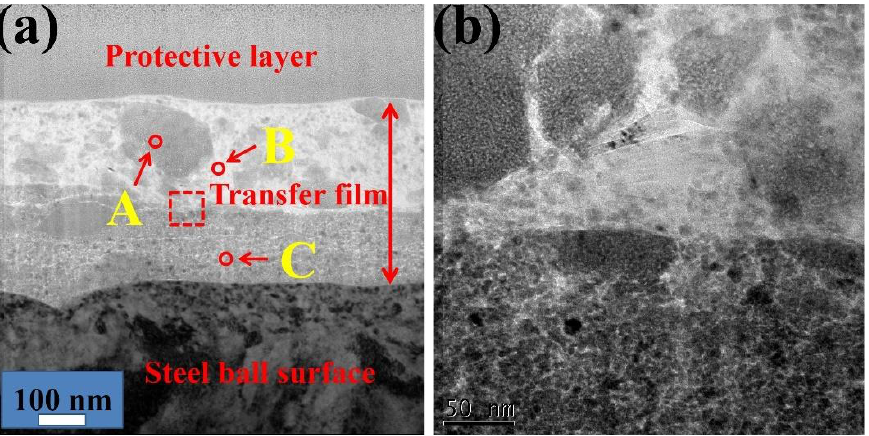
Figure 9. ( a ) Cross-sectional TEM image of the worn surface under the lubrication of LP + 0.5 wt % NSPs after sliding for 4 h and ( b ) enlarged TEM image of red box in ( a ).